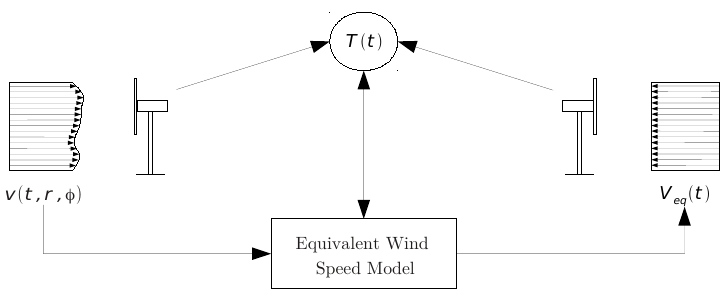
Figure 5. Scheme of the equivalent wind speed.